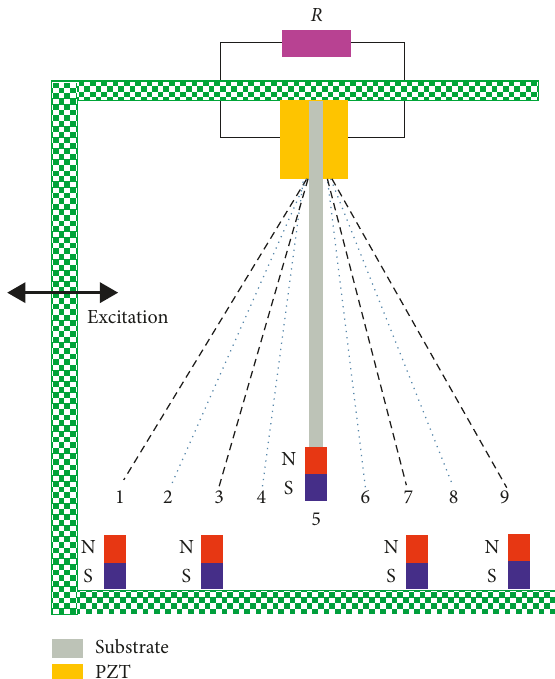
Substrate Figure 1: Structural diagram of the piezoelectric vibrational pentastable energy